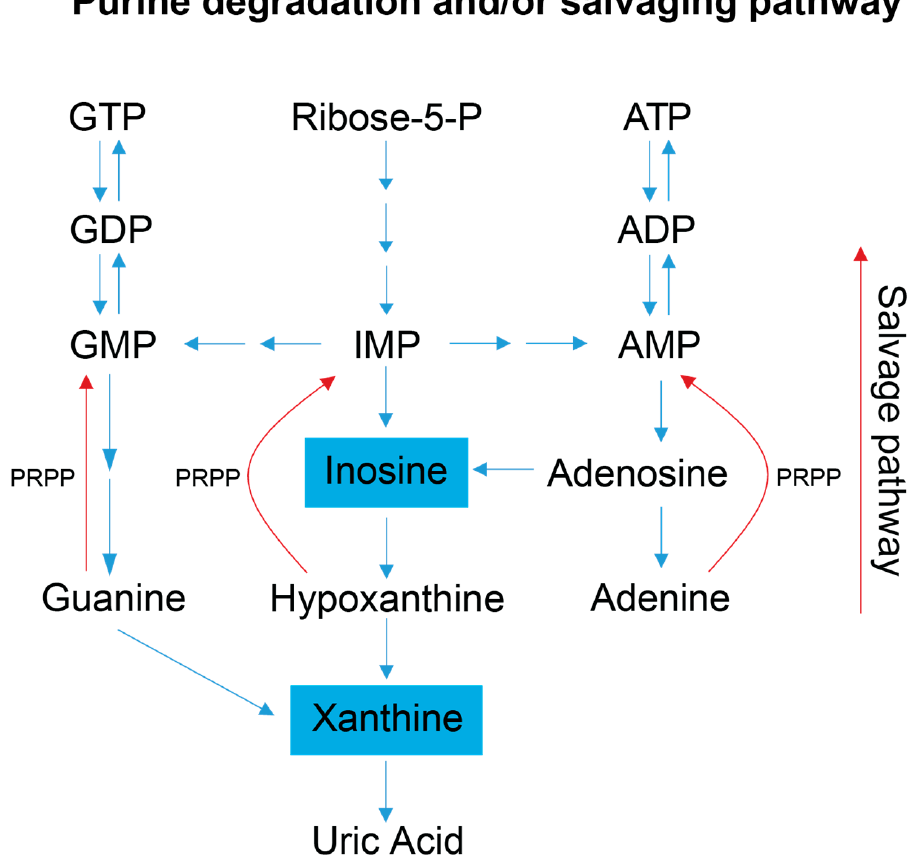
Figure 4. Simplified schematic of the purine salvage pathway. This diagram highlights how a decrease in purine degradation intermediates could reflect the salvaging of purines to preserve energy. Inosine is produced as a result of adenosine deamination via the action of adenosine deaminase and is a key intermediate of purine catabolism in humans, whereas xanthine is generated by the action of xanthine oxidase and is the product of oxidation of hypoxanthine (created via the conversion of inosine) and concomitant reduction of NAD+ to NADH. Additionally, xanthine can be produced via the deamination of guanosine. Xanthine oxidase catalyzes the oxidation of xanthine to uric acid, which is normally excreted in the urine, and was not detected in our metabolite profiling analysis of the serum samples [1,2]. Blue colored metabolites indicate decreased concentration in FD patient sera. Abbreviations: PRPP, phosphoribosyl pyrophosphate; IMP, inosine monophosphate; AMP, adenosine monophosphate; ADP, adenosine diphosphate; ATP, adenosine triphosphate; GMP, guanosine monophosphate; GDP, guanosine diphosphate; GTP, guanosine triphosphate.